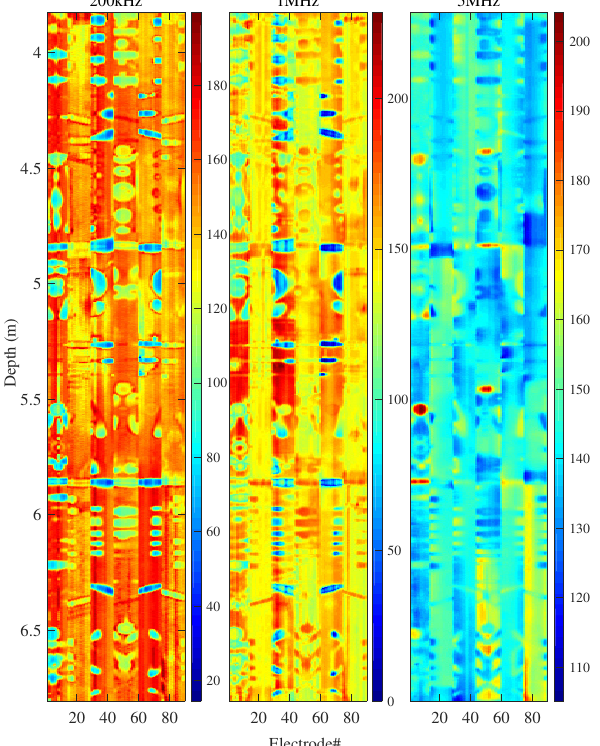
Figure 14. The imaging result of borehole wall patterns with UMMAI sample phases in the second test, while the borehole is filled with water-based